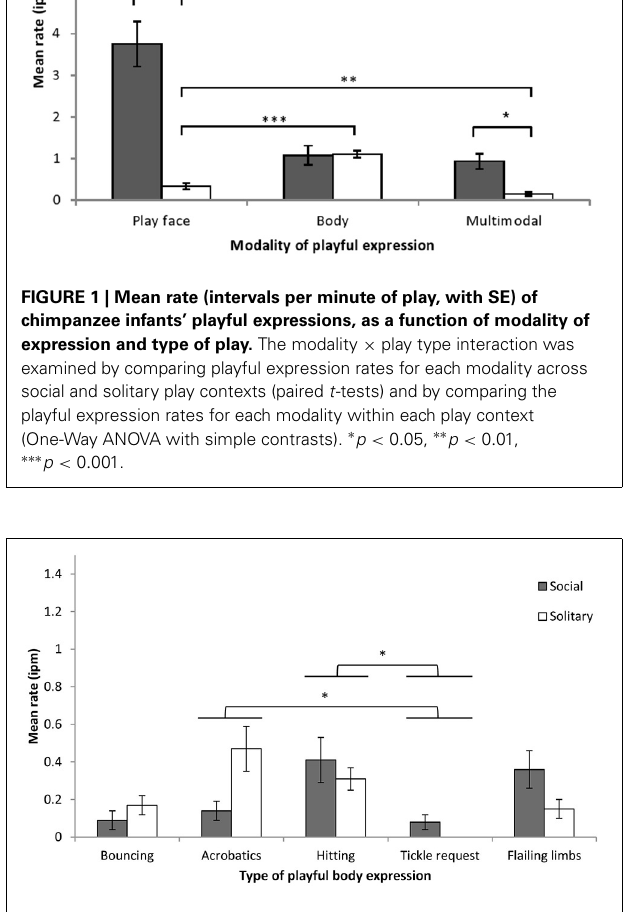
FIGURE 2 | Mean rate (intervals per minute of play, with SE) of chimpanzee infants’ playful body expressions during social and solitary play. ∗ p < 0 .